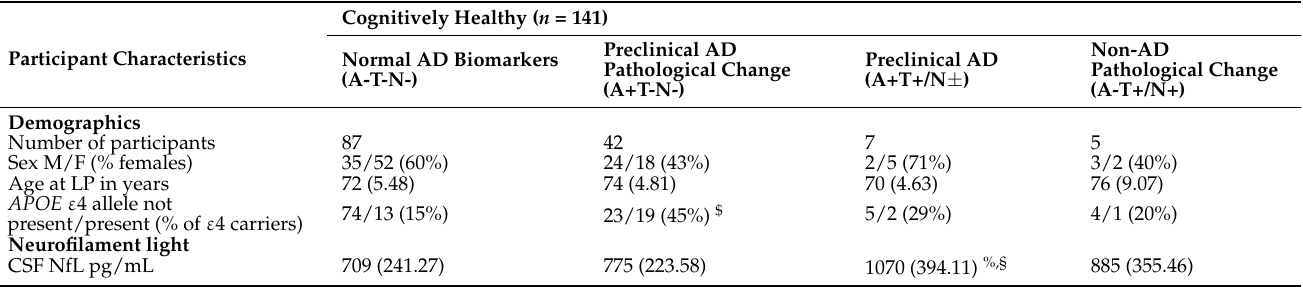
Table 1. Demographic and biomarker characteristics of cognitively healthy participants segregated using the biomarker guided ATN classification